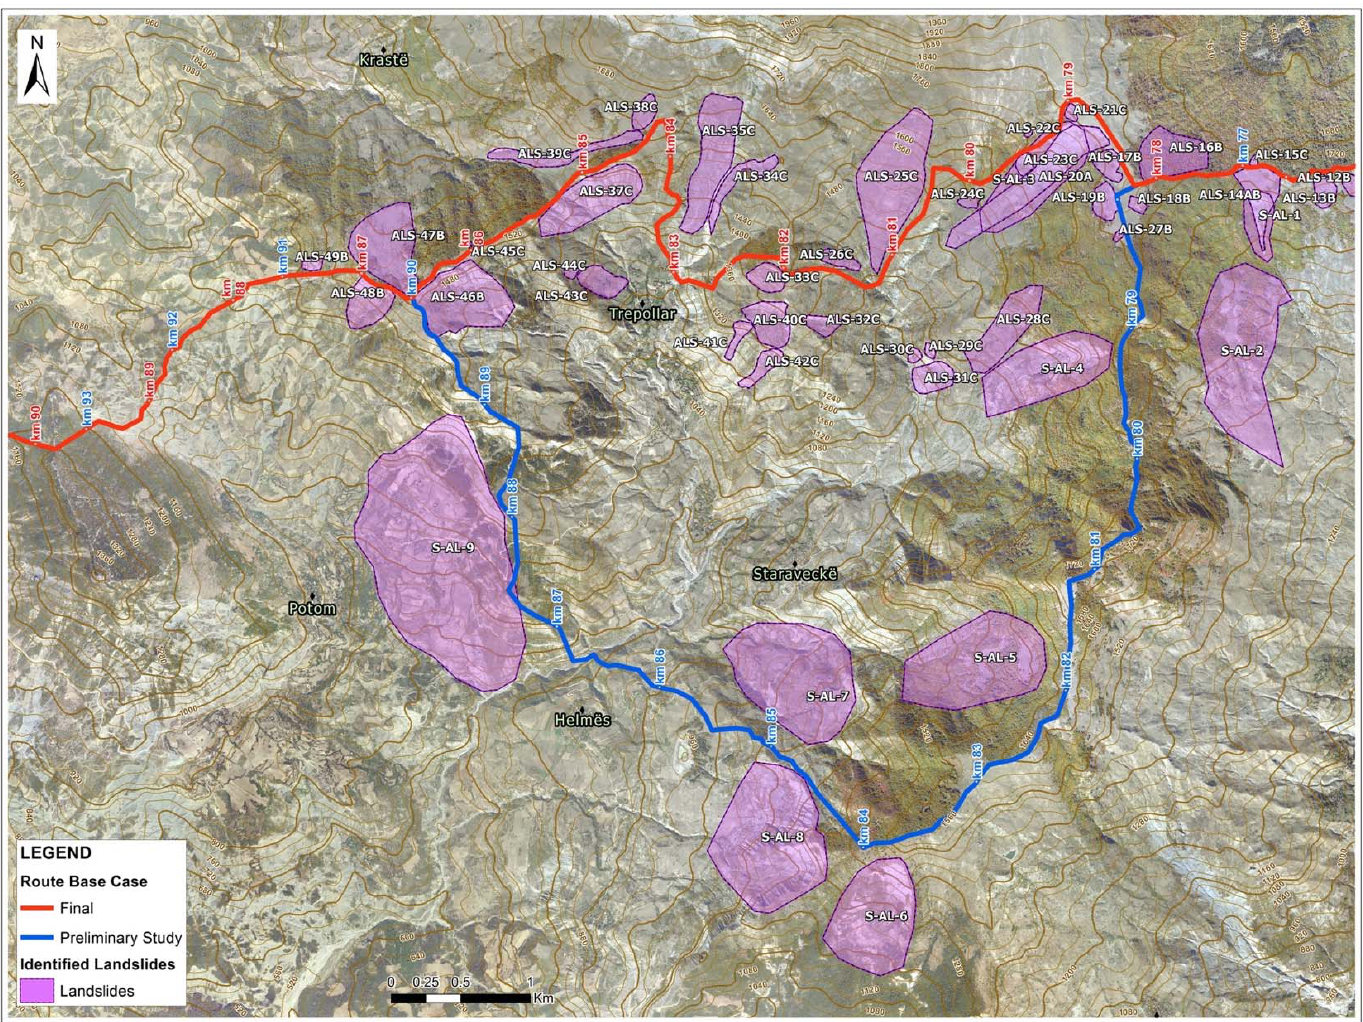
Figure 6. Combination of weak rocks, steep slopes, rainfall and snow melt and strong ground accelerations (earthquakes) creates an environment prone to landsliding.